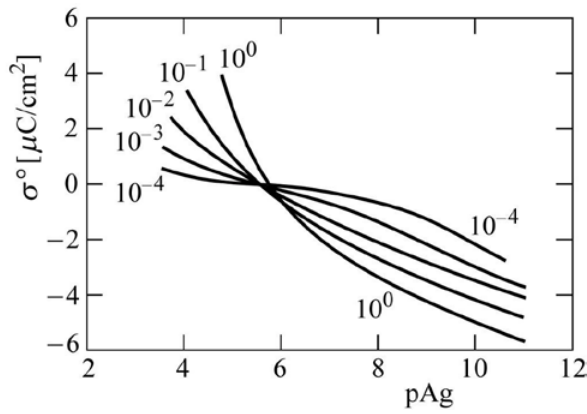
Figure 5. Surface charge as a function of pAg for silver iodide. T = 25 o . Electrolyte, KNO 3 . The pAg axis may also be read as a ψ ° axis with 58 mV per unit of